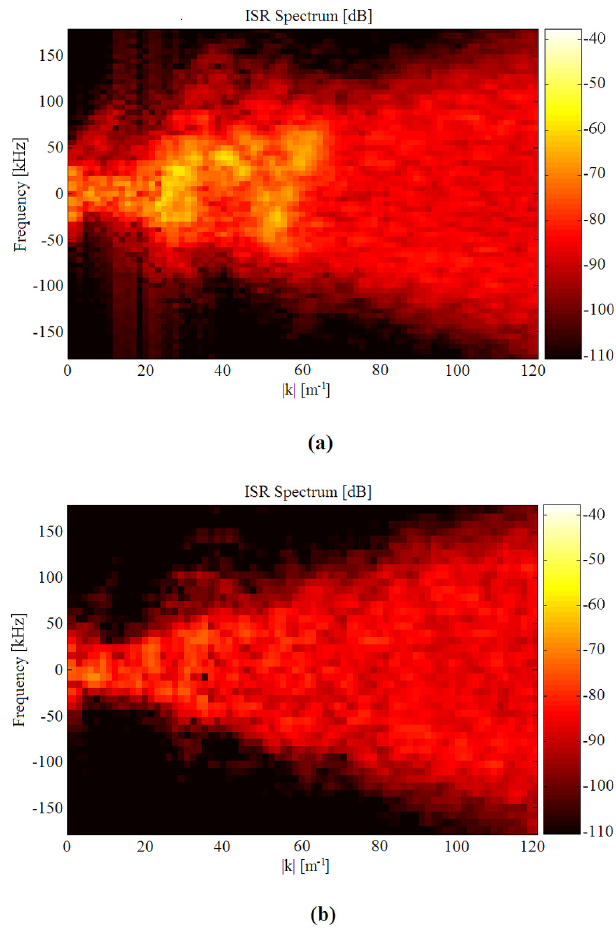
Fig. 9. Ion acoustic line of the incoherent scatter spectrum for simulations with parameters presented in Sect. 3.2 for (a) v b = 6 . 75 × 10 5 ms − 1 and (b) v b = 4 . 9 × 10 5 ms − 1 . The spectrum as- sociated with v b = 7 . 8 × 10 5 ms − 1 is shown in Fig. 6b.